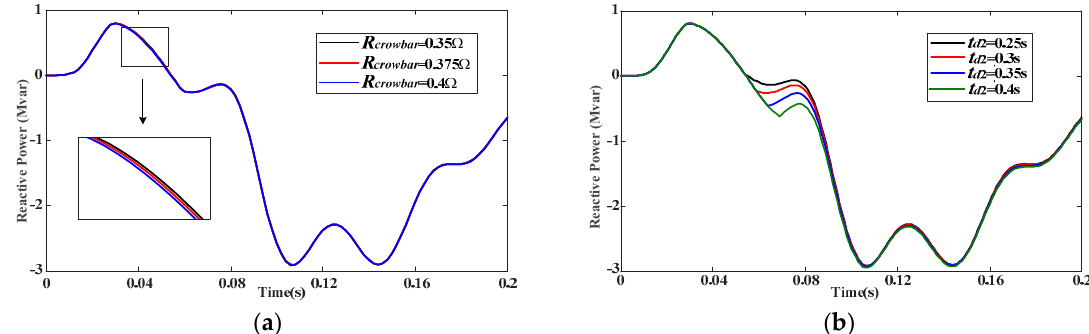
Figure 12. Reactive power characteristics of DFIG under different crowbar parameters. ( a ) Actual crowbar resistor value ( t d 2 = 0.3s); ( b ) minimum connection time ( R crowbar = 0.35 Ω ).